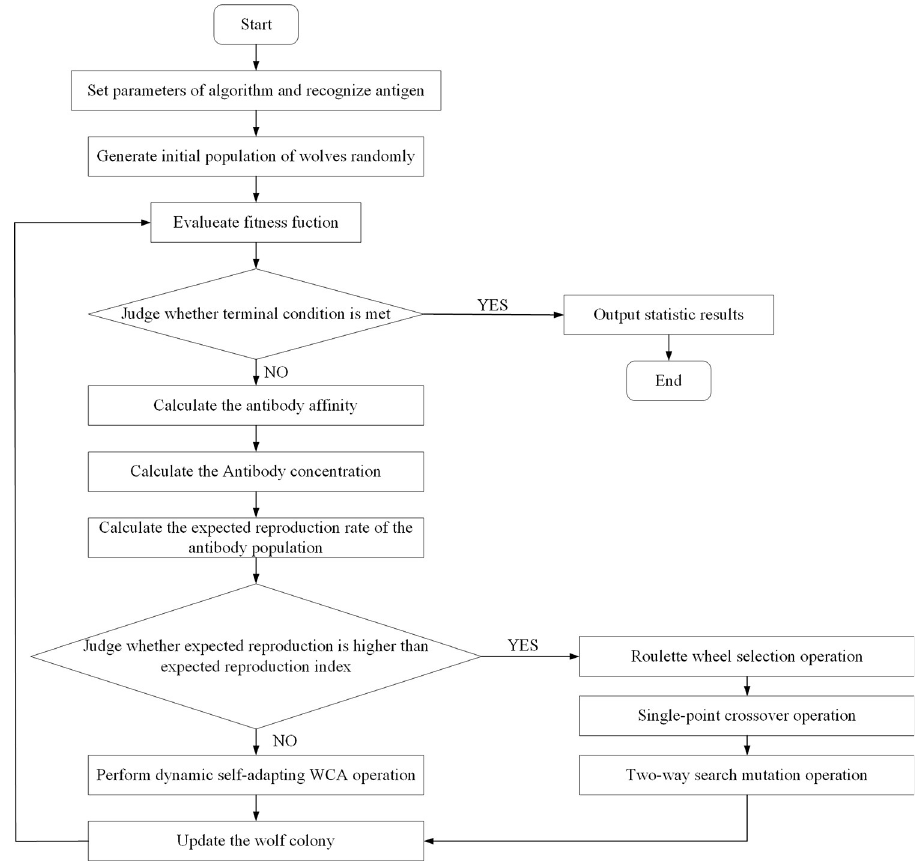
Fig 11. Flowchart of immune wolf colony